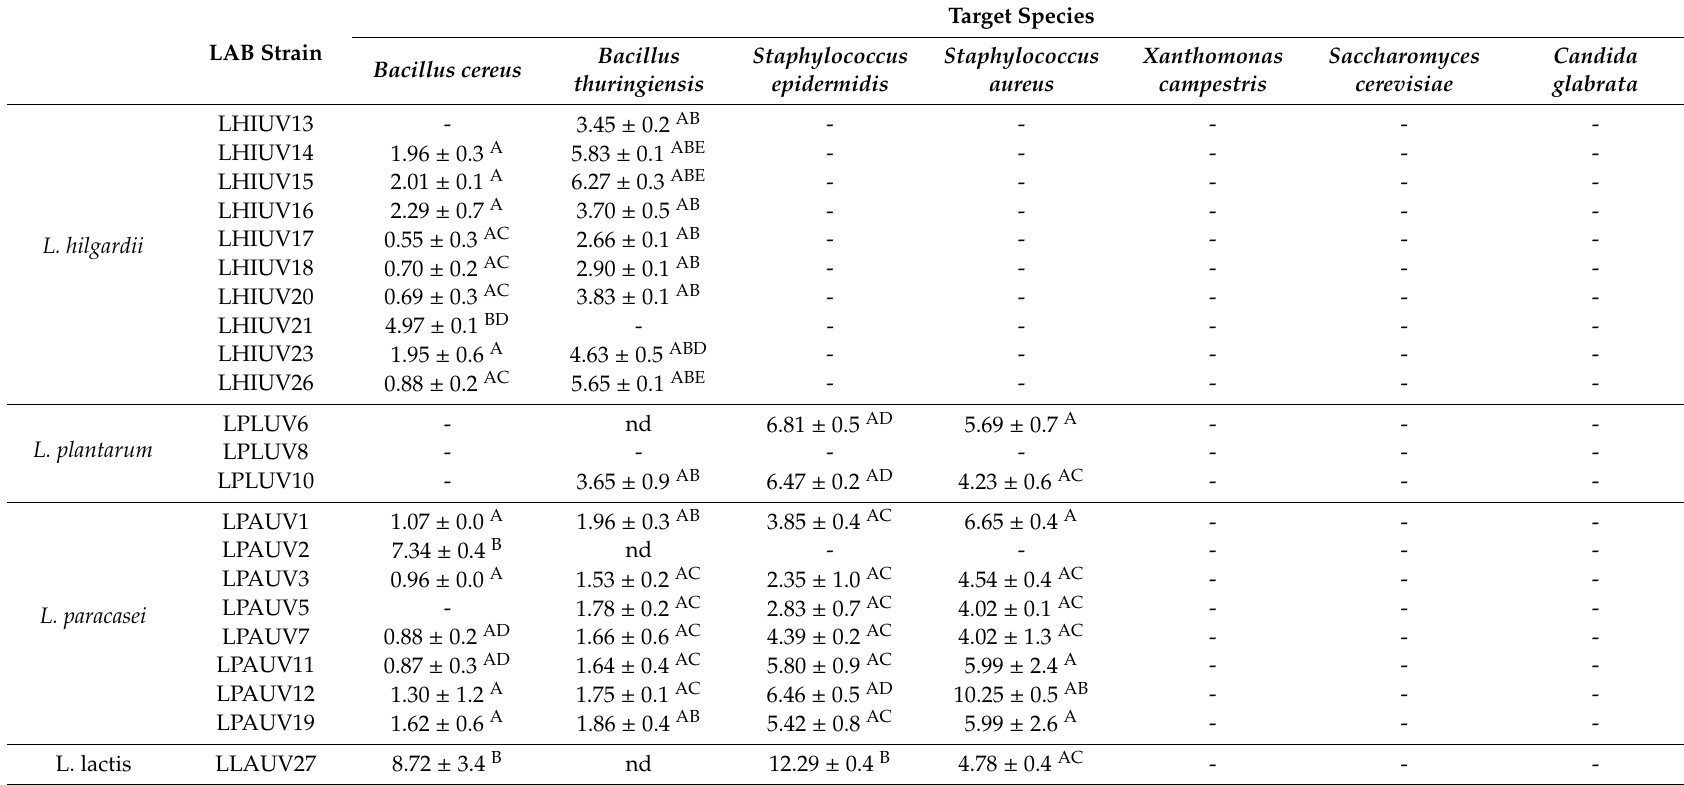
Table 1. Antimicrobial activity of lactic acid bacteria against target